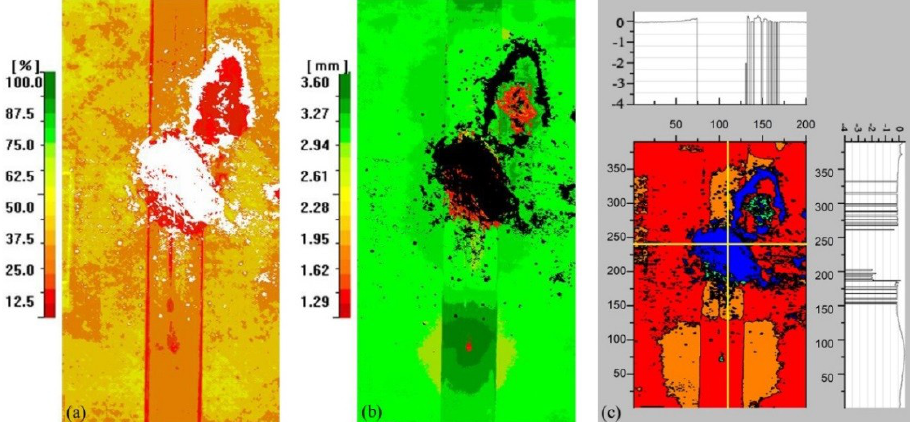
Figure 10. Echo amplitude, echo location and location data for composite-reinforced panel with full copper mesh filling: ( a ) echo amplitude; ( b ) echo location; ( c ) location data (Unit: mm).